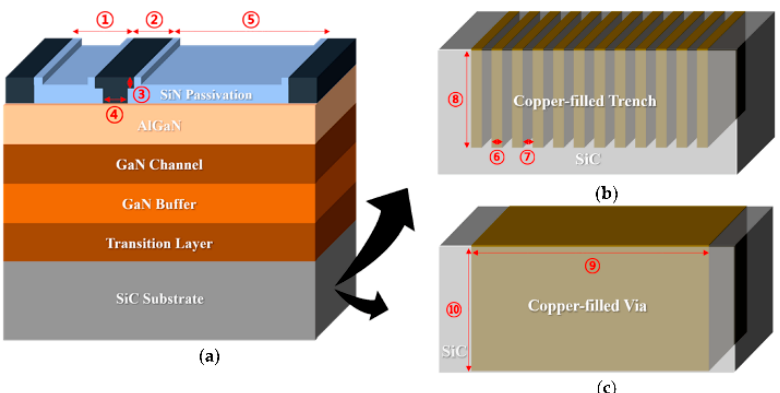
Figure 10. Structures of ( a ) AlGaN/GaN HEMT on SiC, ( b ) Cu-filled thermal trench, and ( c ) CTV in SiC substrate. The lattice temperature within the 2DEG channel was lowered, thus improving breakdown voltage, saturation current, drain current, and peak transconductance. Reprinted with permission from ref. [137]. Copyright 2020